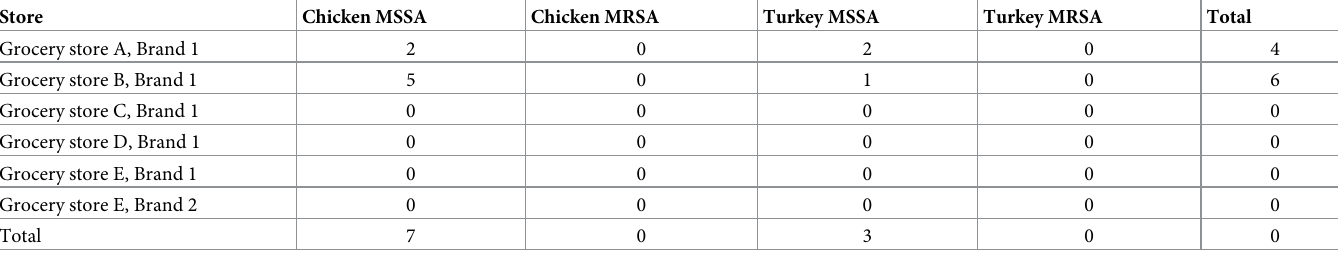
Store locations and specific isolates per store are listed to show that SA isolates were collected from diverse